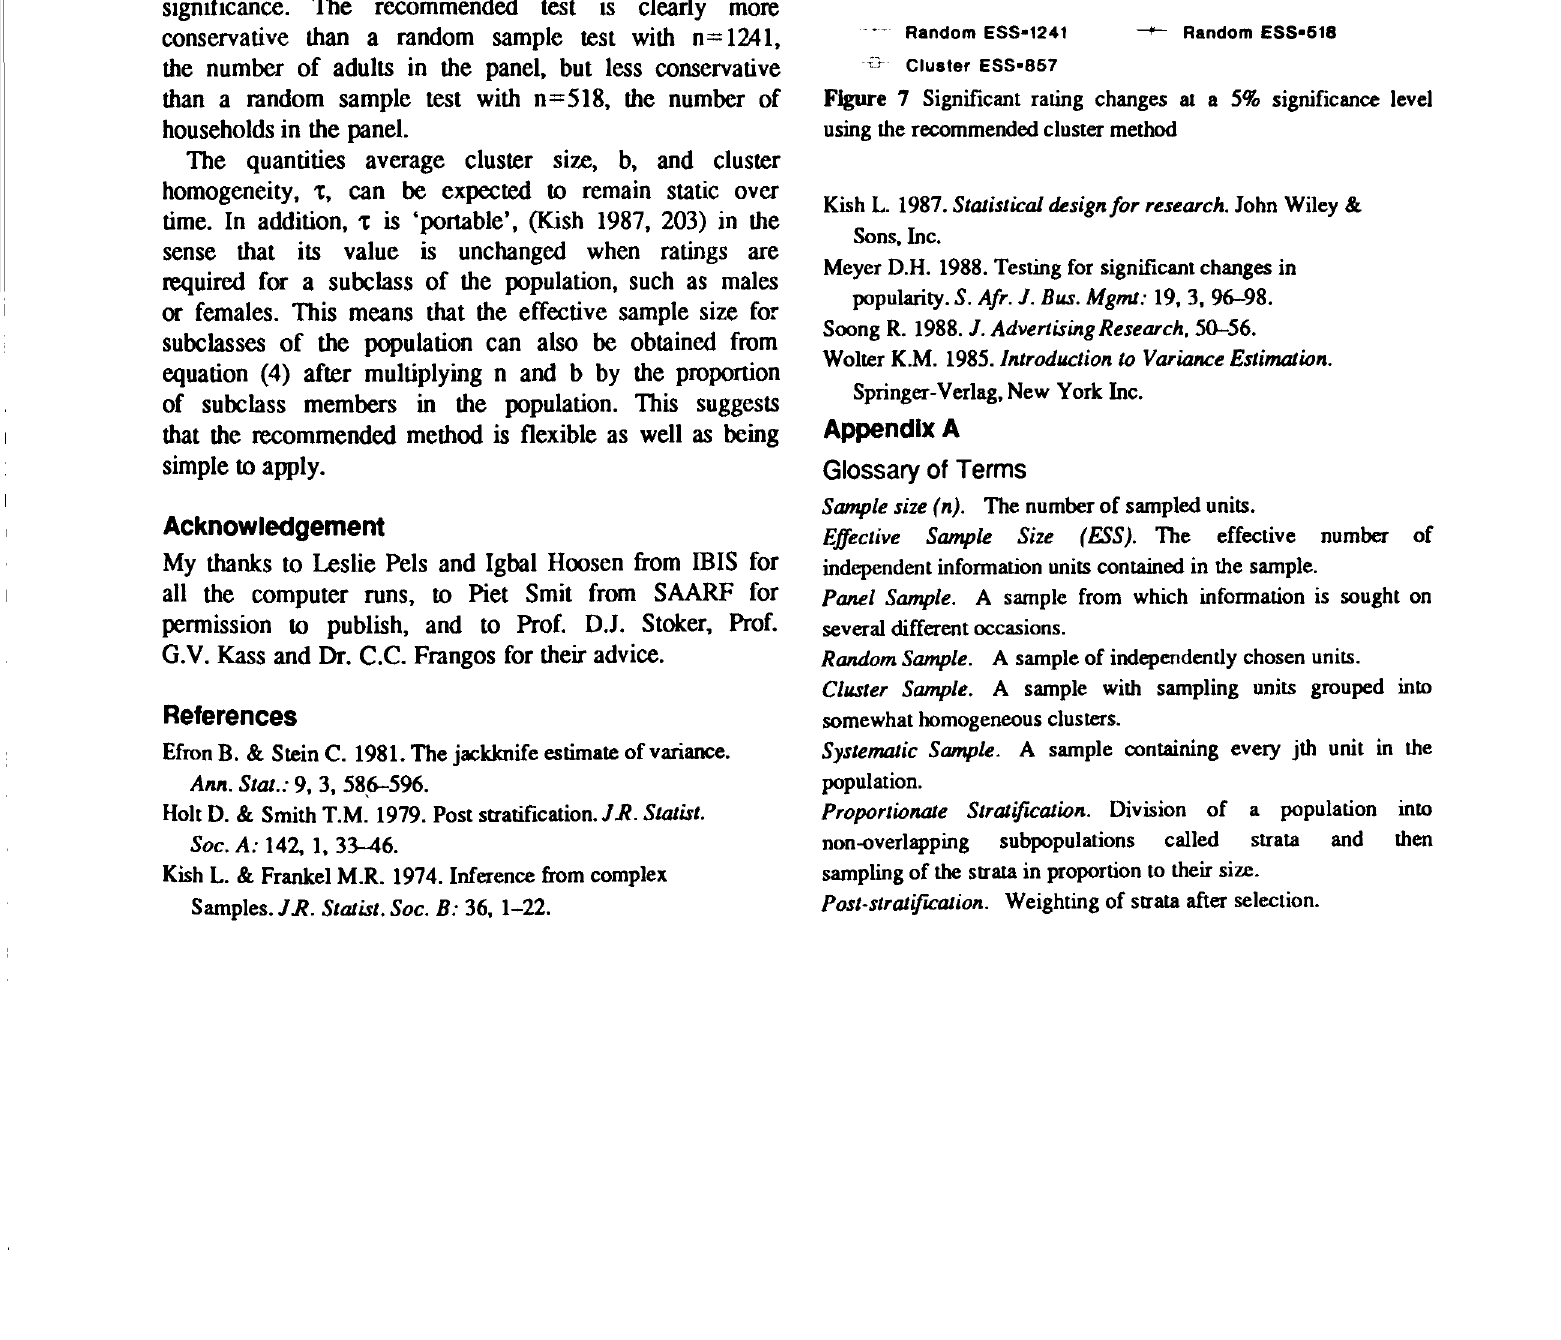
Figure 7 Significant rating changes at a 5% significance level using the recommended cluster method